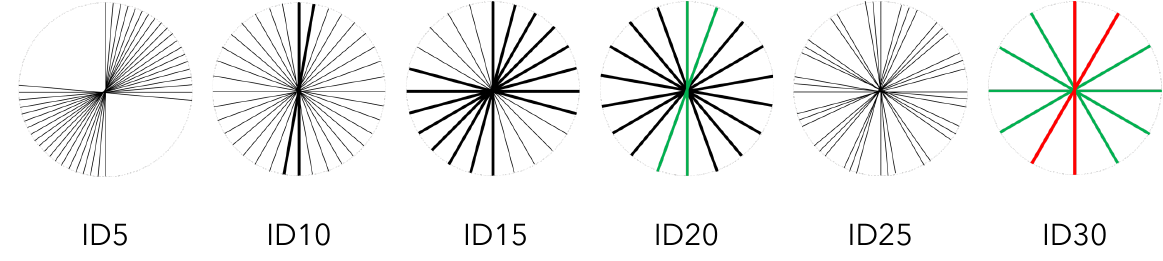
Figure 1. Pictorial representation of the laminate stacking sequences. Here, lines indicate the prepreg stacking angle. Black thin lines indicate a single laminate is present in the composite at a particular stacking angle, a thick black line indicates that two laminates are present in the composite at a particular stacking angle, a thick green line indicates that three laminates are present in the composite at a particular stacking angle, and a thick red line indicates that four laminates are present in the composite at a particular stacking